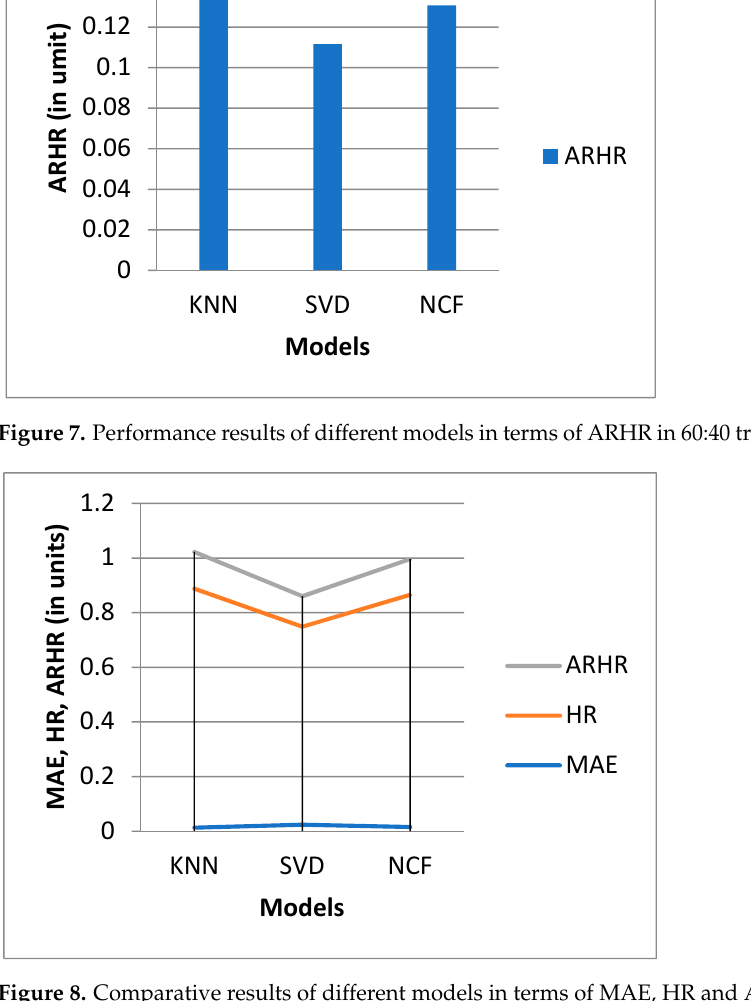
Figure 8. Comparative results of different models in terms of MAE, HR and ARHR in 60:40 training–testing scenario.